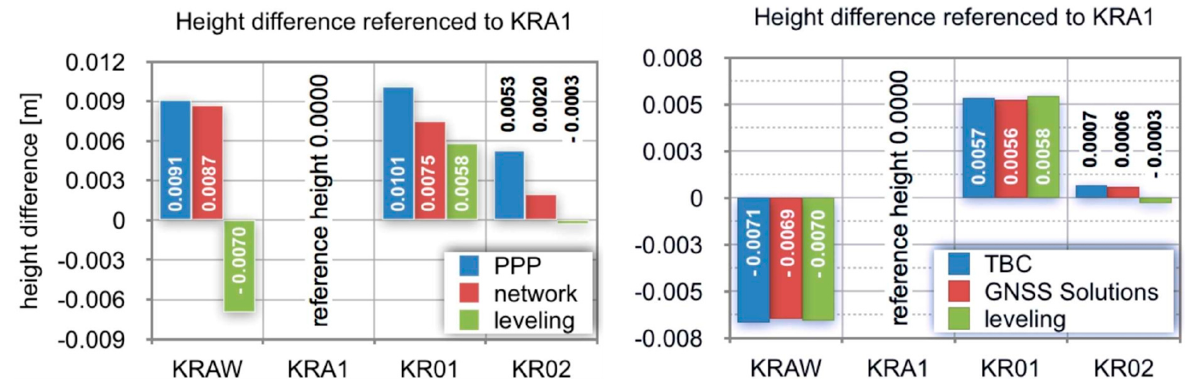
Figure 6. Differences between the heights obtained with PPP and a network solution ( left ) and single baseline solutions ( right ) [32].